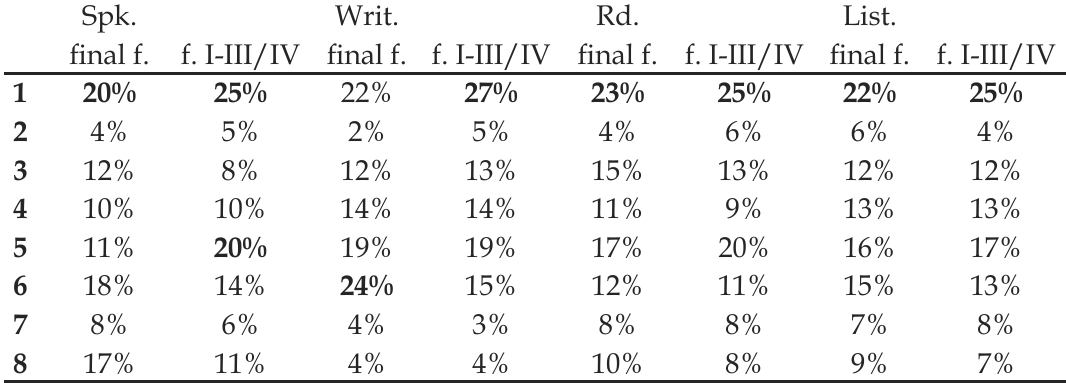
Table 5. Frequency of formative assessment provision in the case of FL skills Spk. Writ. Rd. List. (cid:192) nal